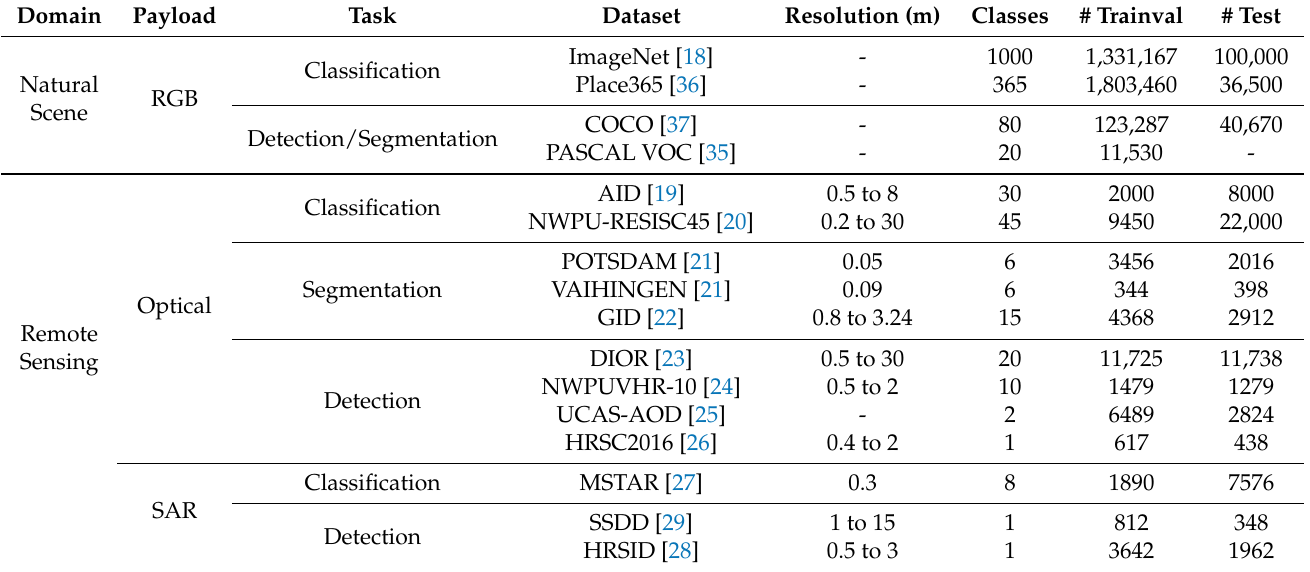
Figure 1. The different types of imaging data in remote sensing domain. Table 1. The description of natural scene and remote sensing